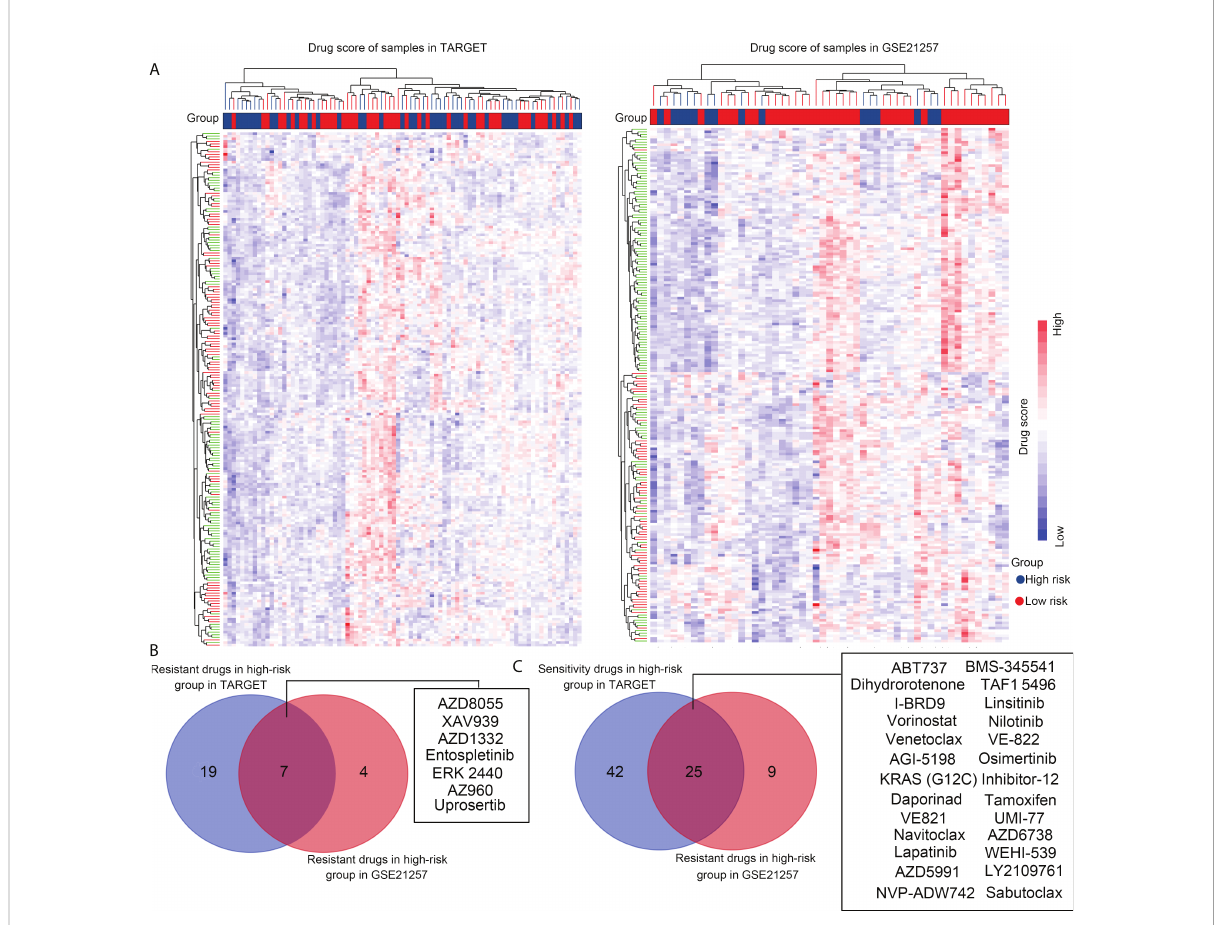
FIGURE 9 Selecting suitable drugs for high-risk group patients with OS via OncoPredict. (A) OncoPredict was used to transform the gene expression pro fi le of OS tissues in the TARGET and GSE21257 groups into a drug sensitivity matrix of 198 drugs. (B) Resistant drugs identi fi ed in high-risk groups in both the TARGET and GSE21257 cohorts. (C) Sensitive drugs identi fi ed in high-risk groups in the TARGET and GSE21257